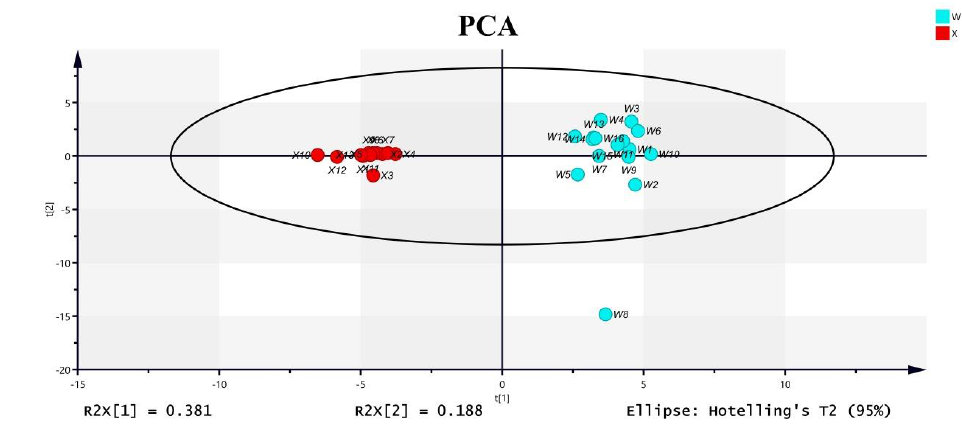
Figure 4. PCA classification results of Acanthopanacis Cortex (W) and Periplocae Cortex (X) based on GC-MS data.